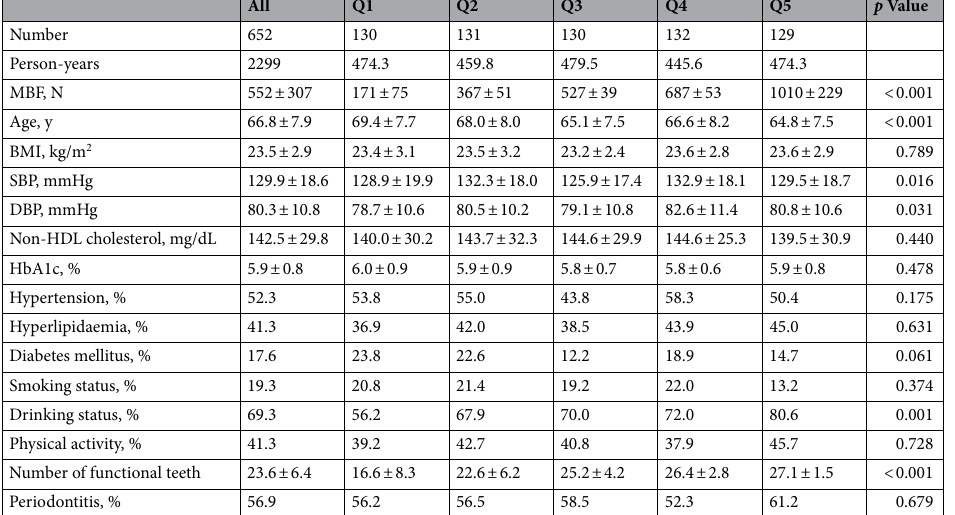
Table 2. Subjects’ baseline characteristics by MBF quintiles in men. Data are frequencies or means ± SD. MBF, maximum bite force; BMI, body mass index; SBP, systolic pressure; DBP, diastolic blood pressure; HDL, high- density lipoprotein-cholesterol; Physical activity, ≥ 60 min walking per day. Analysis of variance was used for comparisons of multiple group means, and the Chi-squared test was used to compare frequencies.